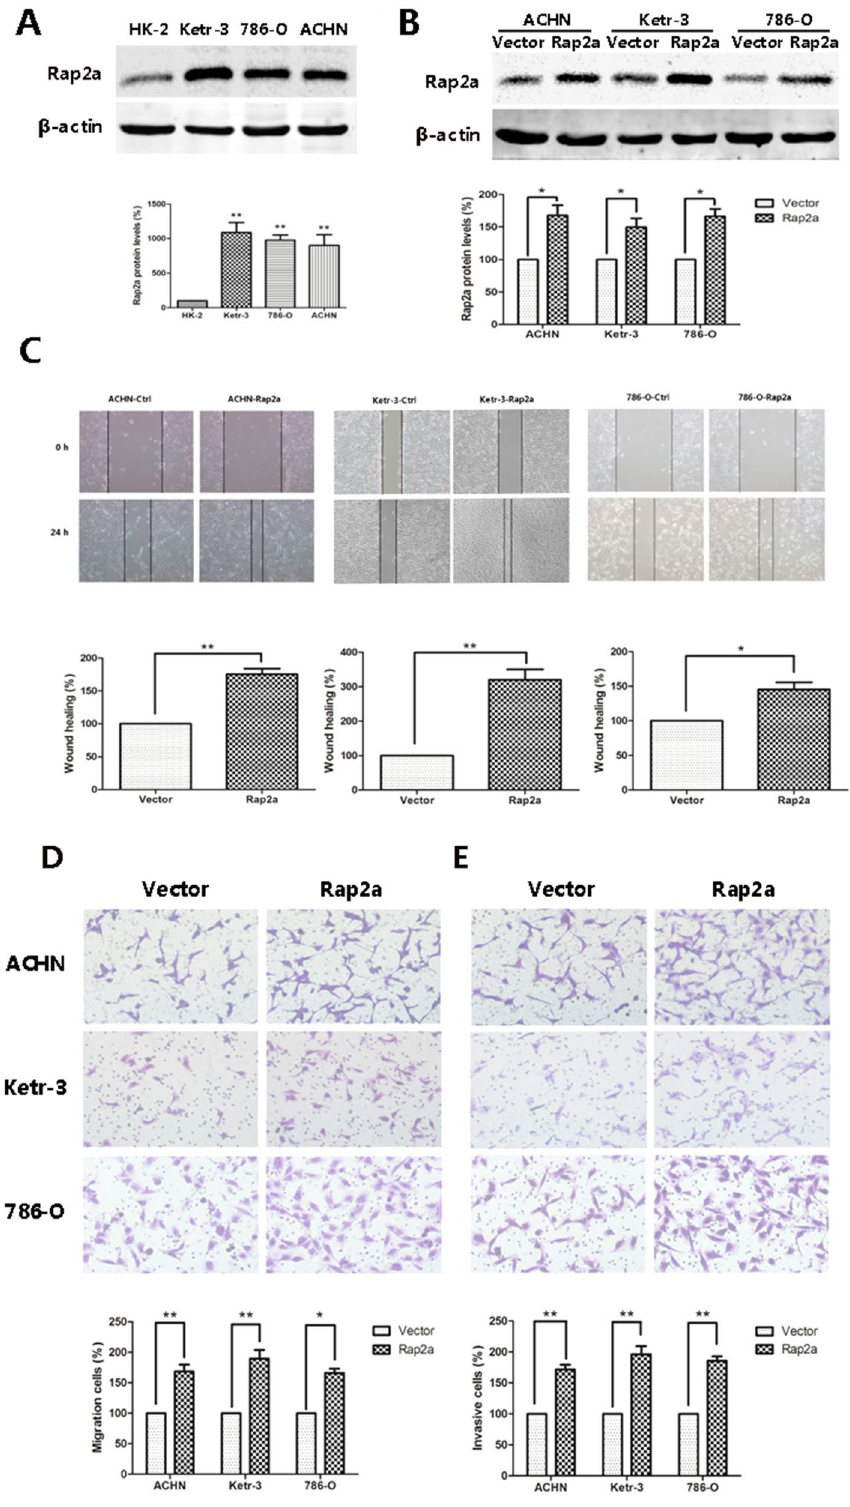
Figure 2. Effects of Rap2a overexpression on invasion and migration in RCC cells. ( A ) Western blot analysis of Rap2a expression in HK-2, Ketr-3, 786-O and ACHN. β-actin served as loading control. The intensity of Rap2a was quantified by densitometry (software: Image J, NIH). ( B ) ACHN, Ketr-3 and 786-O cell lines were transfected with Rap2a expressing or empty vector. Twenty-four hours post-transfection, Rap2a protein expression was detected by western blot. ( C ) Wound- healing assays were performed after Rap2a overexpression in ACHN, Ketr-3 and 786-O cells. ( D , E ) Cell migration was measured by using a migration assay following the transfection of RCC cells with Rap2a expression plasmid. Invasion assays were performed by using a similar procedure, except the polycarbonate filters was coated with Matrigel. Data are presented as mean ± SD (n = 3). * P < 0.05, ** P <